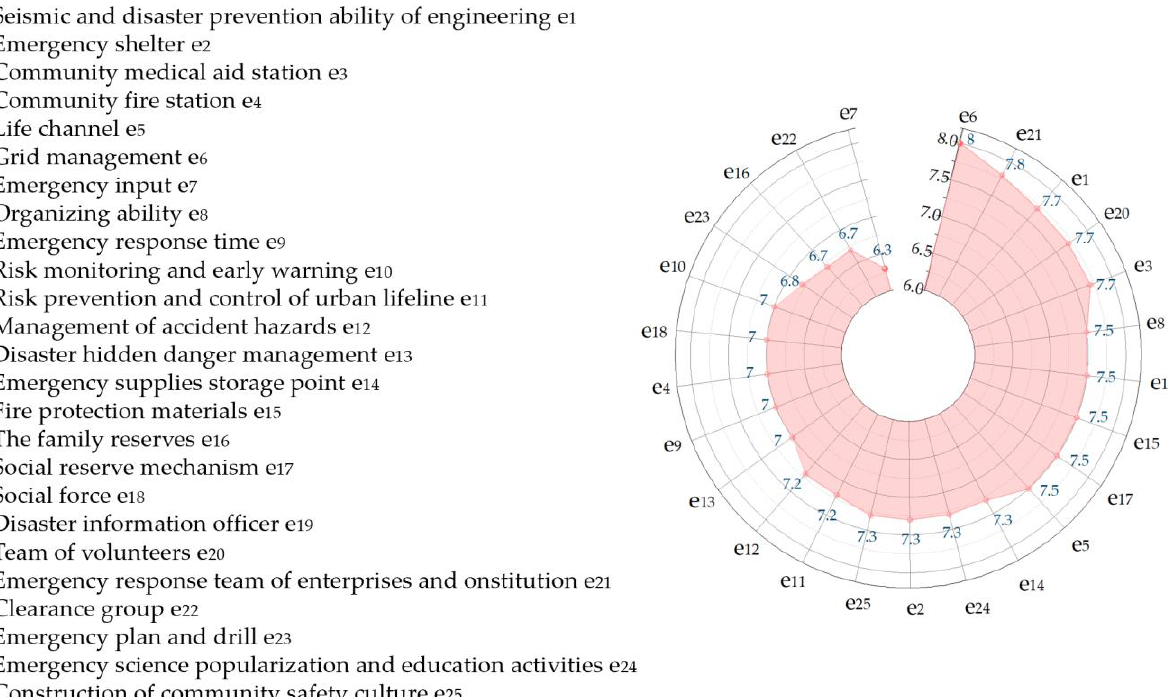
Figure 5. Evaluation quantification chart.